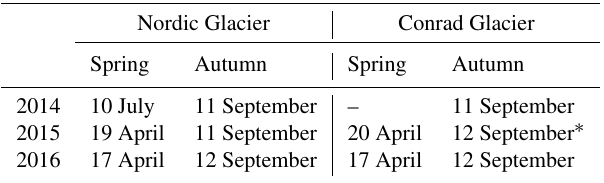
Table 3. Dates of lidar flights over the two study glaciers from 2014 to